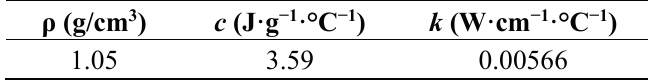
Table 2. Thermal and physiological properties of liver tissue